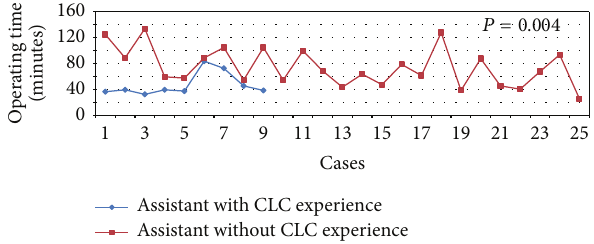
Table4:Meanoperatingtimes,conversionrate,andpatients’profile of Surgeons A after the first 19 cases.